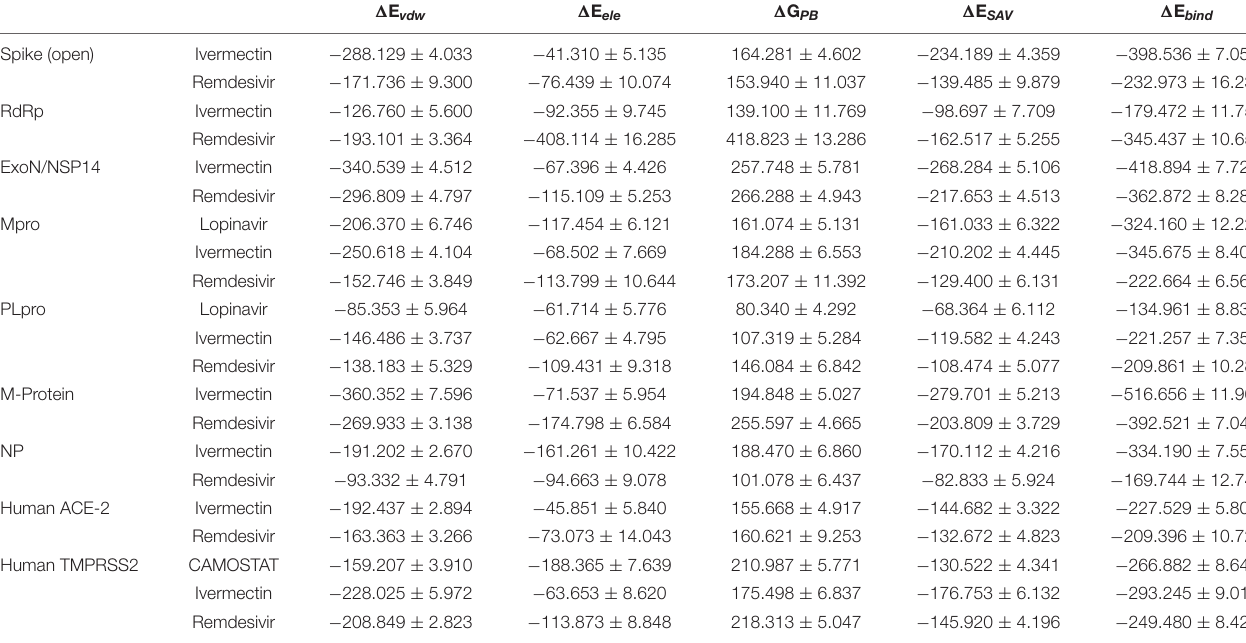
TABLE 7 | Calculated MM-PBSA energy